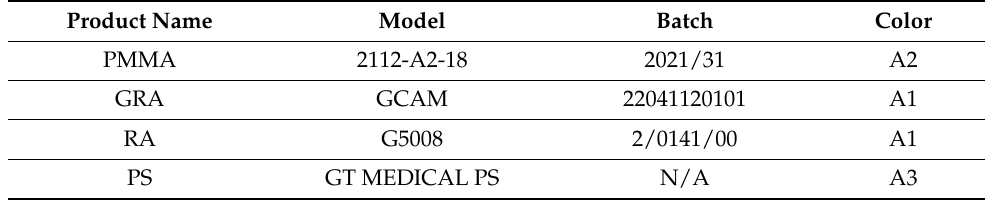
Table 1. Summary of materials used in the